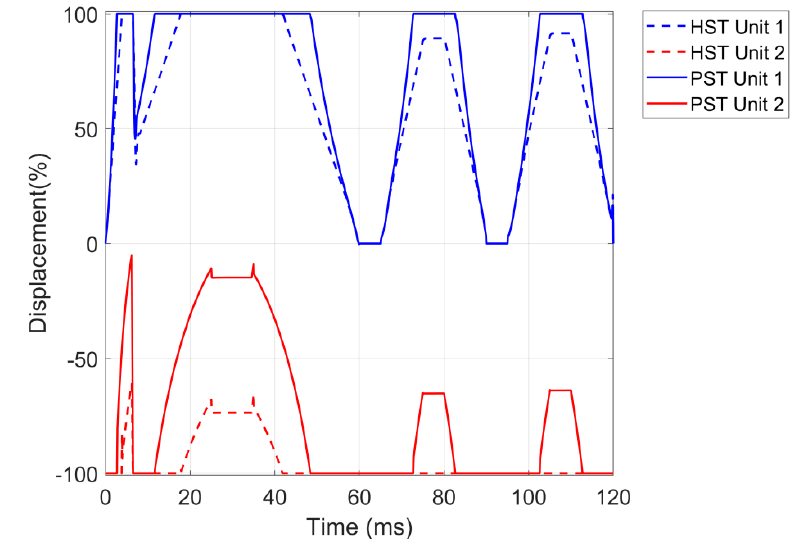
Figure 11. The controlled displacement profiles of Units 1 and 2.